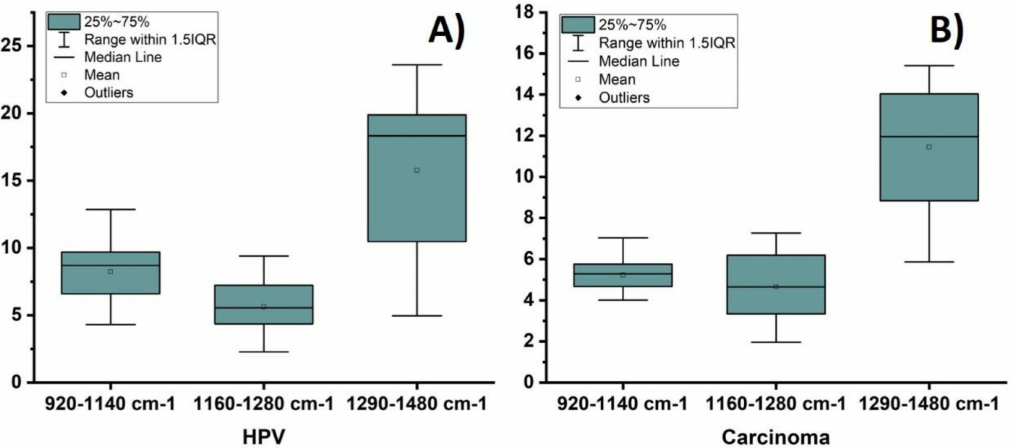
Figure 5. A plot of the integrated SERS regions 920–1140 cm − 1 , 1160–1280 cm − 1 and 1290–1480 cm − 1 , respectively. Each point represents the average value from three SERS spectra and error bars show the standard deviations. SERS spectra of cervical tissues. ( A ) Tissue infected with HPV and marked with Au NPs; ( B ) tissues with carcinoma marked with Au